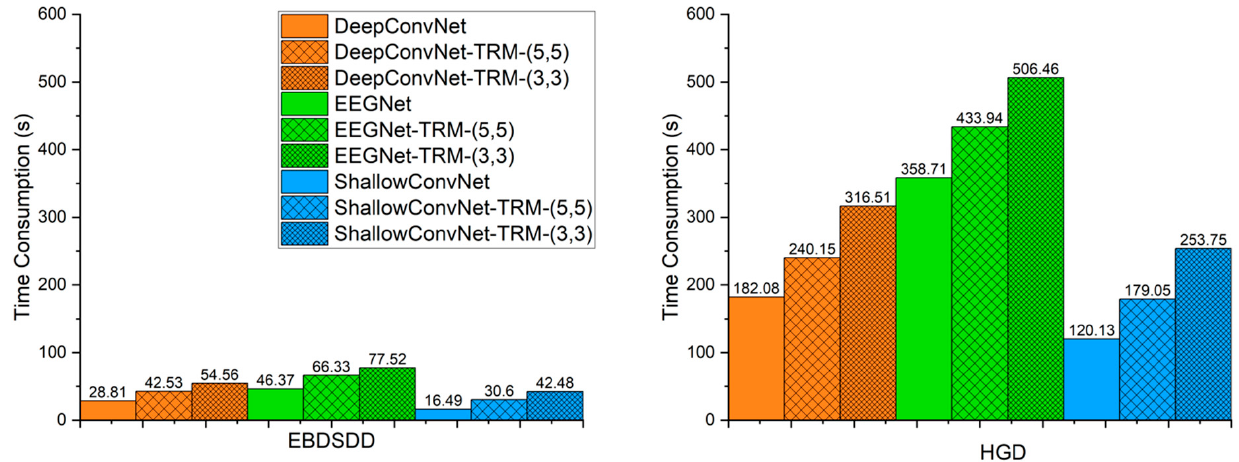
Figure 6. Average time consumption required for training and validation for 300 epochs of algorithms. The left and right panels show the average time consumption on the EBDSDD and HGD, respectively. Algorithms with “-TRM” use the TRM.